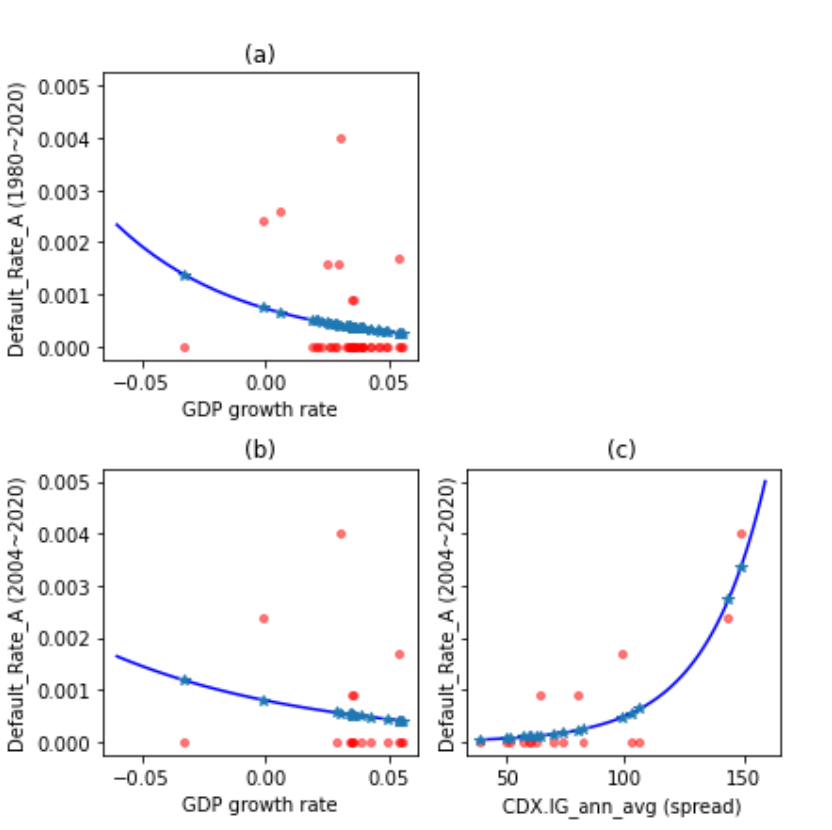
Figure 3. Rating A: logistic regression of DR_A on ( a ) GDP with 1980–2020 data; ( b ) GDP with 2004–2020 data; ( c ) CDX.IG with 2004–2020 data (in Spread).